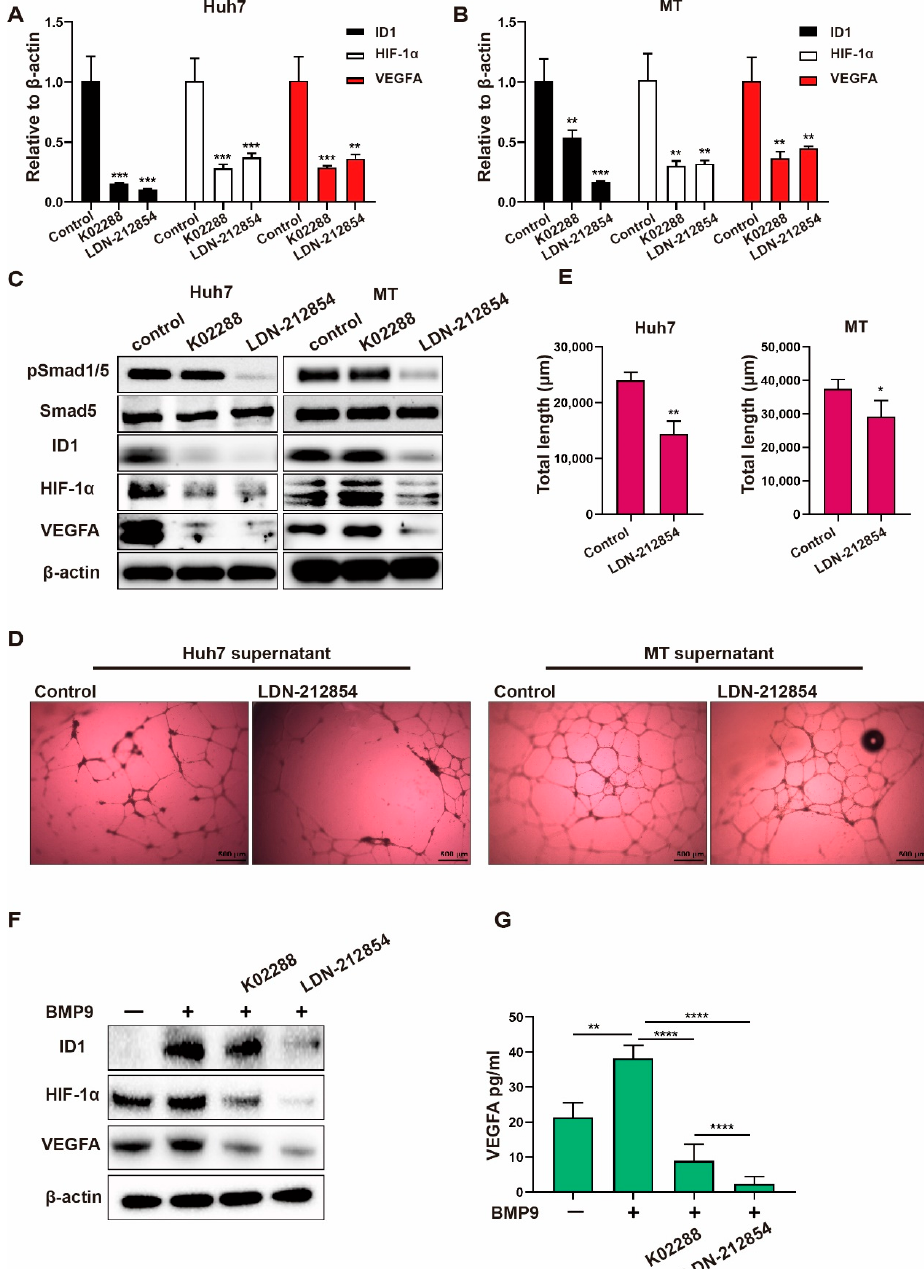
duced upregulation of HIF-1 α /VEGFA expression and VEGFA secretion (Figure 6F,G). Taken together, these findings suggest that BMP receptor inhibitors are potentially prom- ising therapeutic agents inhibiting HCC angiogenesis.